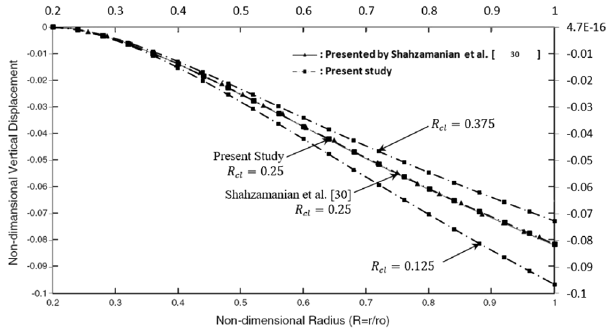
Figure 4. Non-dimensional vertical displacement against the non-dimensional radius.